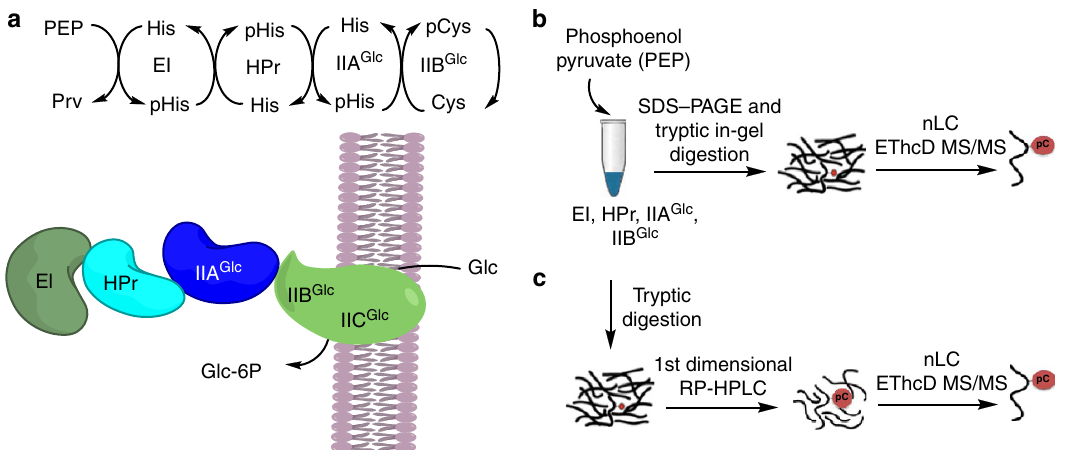
Figure 4 | Characterization of an endogenous pCys peptide by EThcD MS/MS. ( a ) Glucose-specific phosphoenolpyruvate-dependent phosphotransferase system. The phosphate group is transfered from PEP sequentially to the IIB Glc domain of the membrane protein IICB Glc . ( b ) SDS–PAGE in-gel trypsin digeston approach. ( c ) In solution tryptic digestion and offline two-dimensional LC approach.